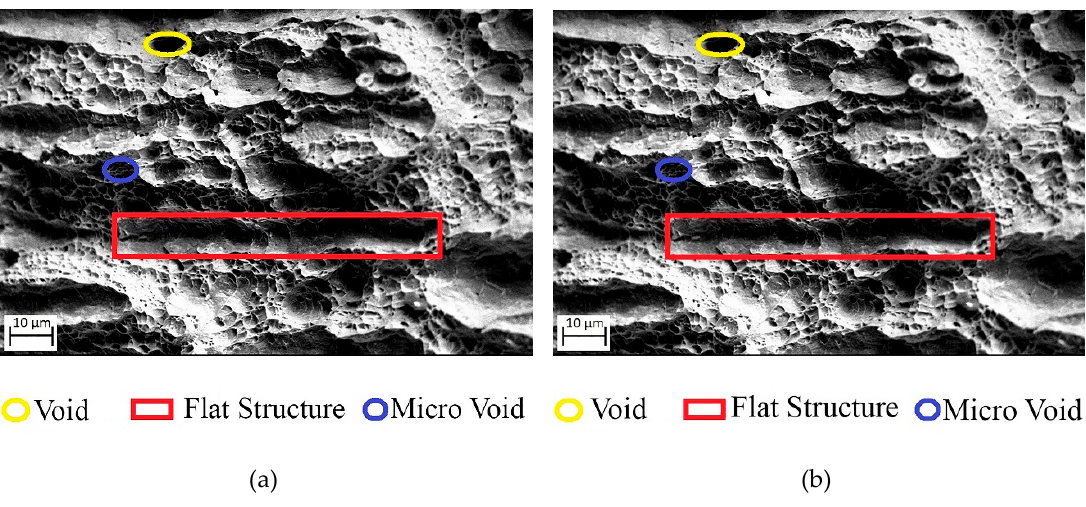
Figure 9. Evaluation of the microstructure via scanning electron microscopy (SEM) after the Charpy test. ( a ) Without the addition of the magnetic field and ( b ) with the addition of the external magnetic field.